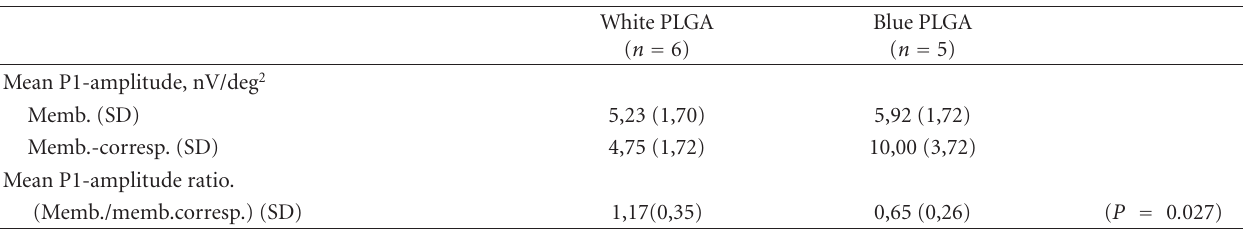
Table 3: E ff ect of color of subretinally implanted membranes upon the multifocal electroretinogram 6 weeks after implantation. White PLGA